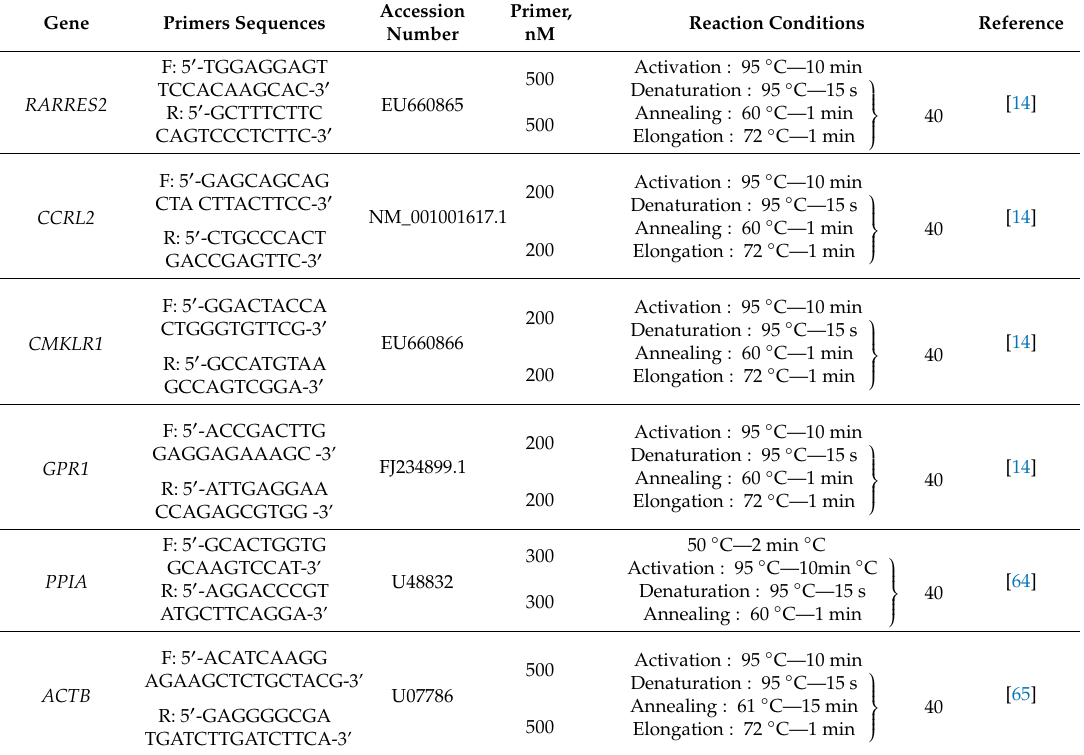
Table 1. Characteristics of the primers used in the study of gene expression in porcine endometrial explants. RARRES2 : Chemerin; CCRL2 : C-C motif chemokine receptor like 2; CMLKR1 :